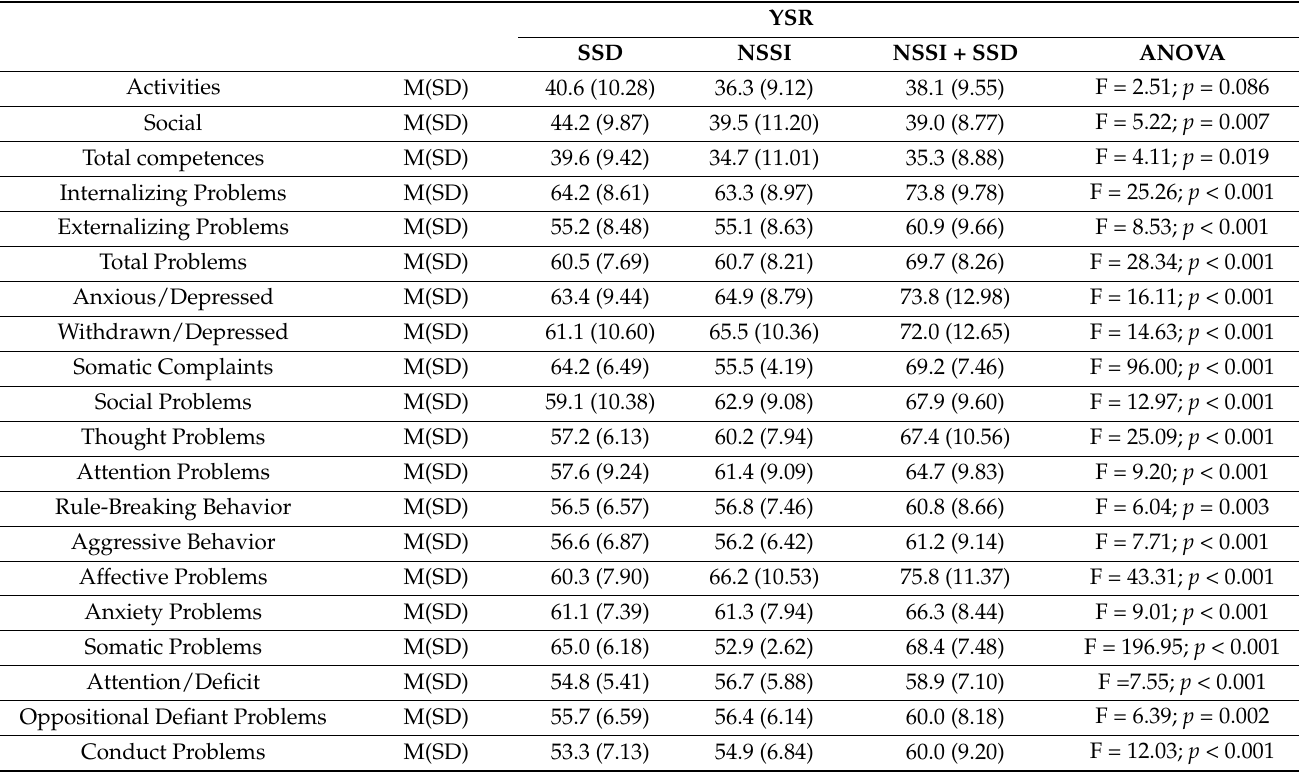
Table 1. Mean scores obtained by the three groups on the Youth Self-Report 11–18 (YSR) scales and differences between the three groups’ psychological profiles on univariate ANOVA.